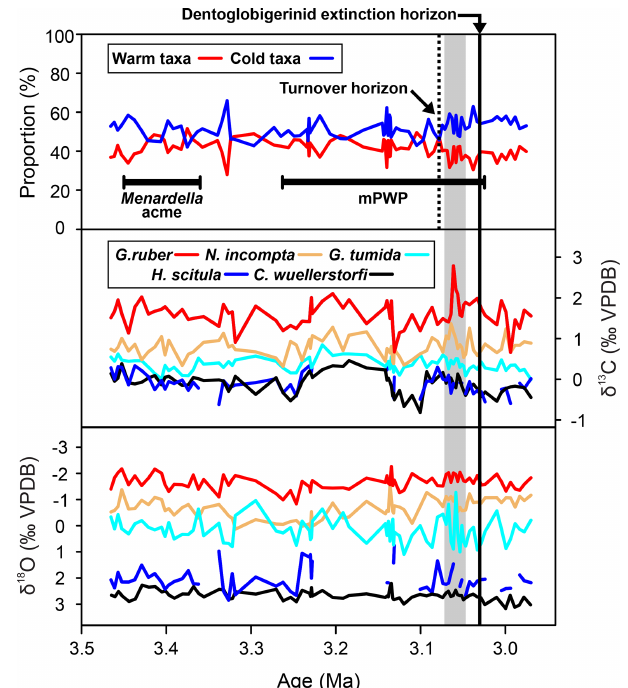
Figure 2. Grouped assemblage data of warm-water taxa (ecogroups “symbiotic” and “asymbiotic”) and cold-water taxa (ecogroups “thermocline”, “subthermocline”, and Globigerinita glutinata (Lutz, 2010; Aze et al., 2011). Foraminiferal δ 13 C and δ 18 O, black = C. wuellerstorfi (bottom water), dark blue = G. scitula (subthermocline), cyan = G. tumida (thermocline), orange = N. in- compta (subsurface), red = G. ruber (surface mixed-layer). The dashed line represents permanent switch to higher proportion of cold-water taxa, and the gray box indicates where isotope records exhibit high volatility, mPWP = mid-Pliocene Warm